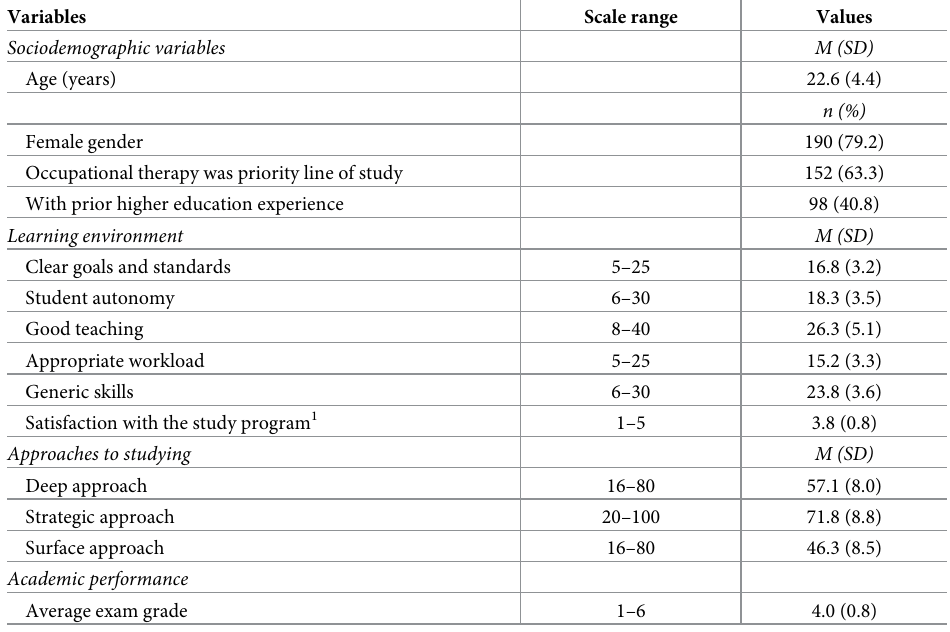
Table 1. Sample characteristics ( n = 240).